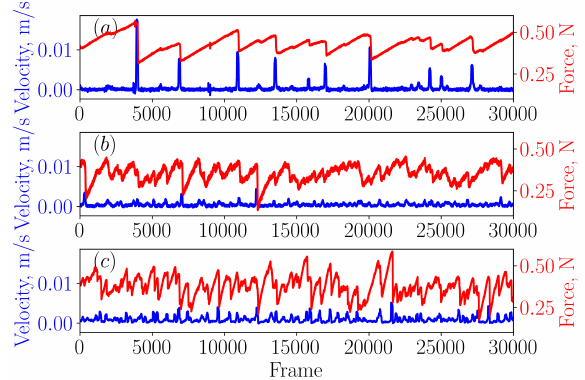
Figure 3: Sliders’ velocity and spring force for the consid- ered experiments: (a) Exp. 1, (b) Exp. 2, (c) Exp. 3.